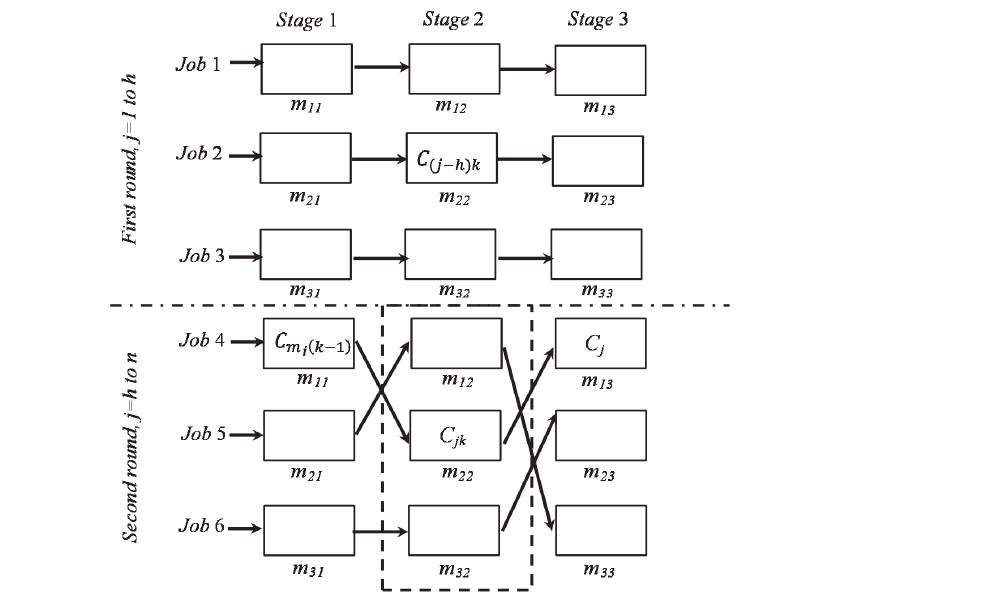
Fig. 1. Illustration of a sample problem in 3 stages production